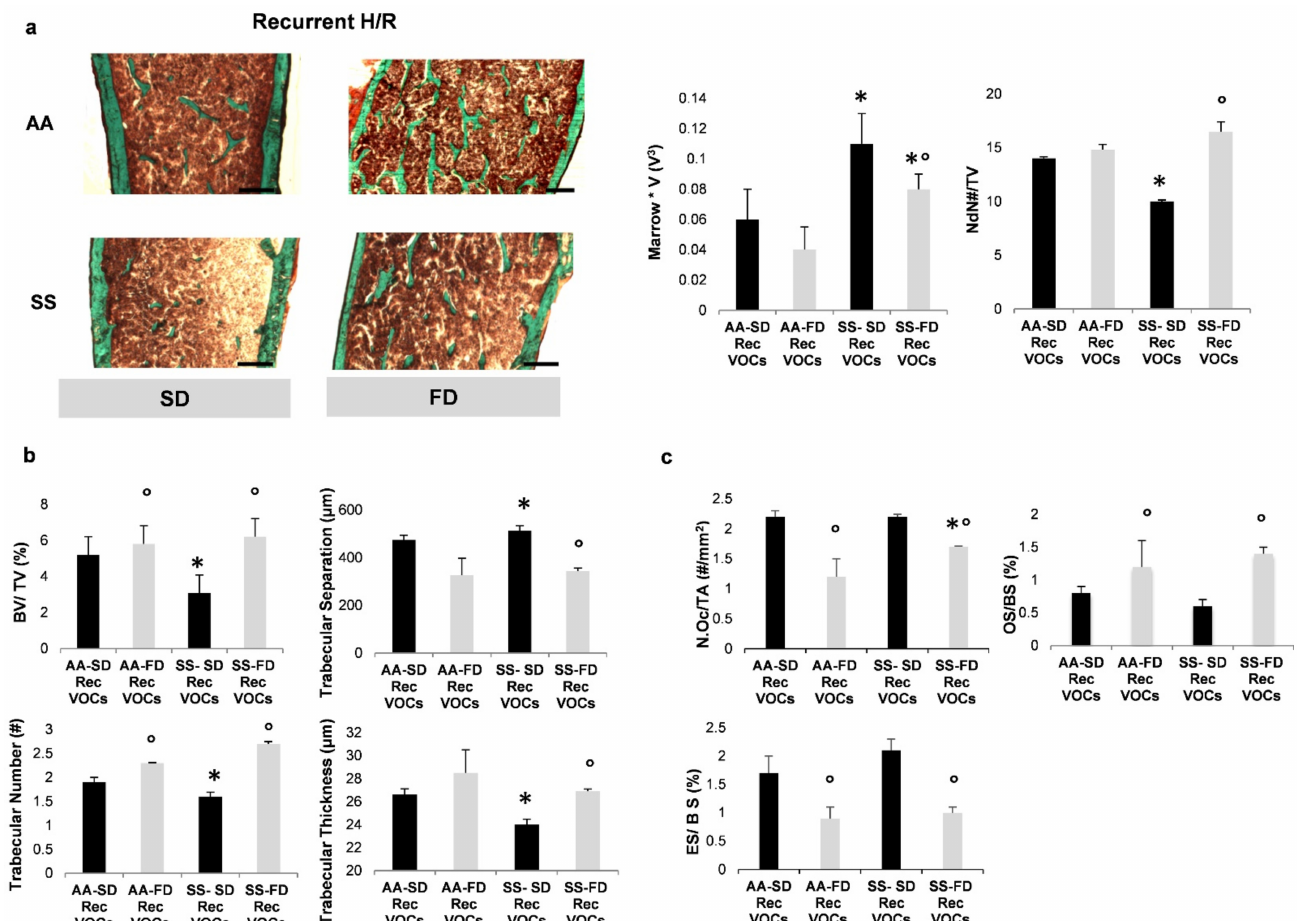
Figure 2. In SCD mice, FD protects bone from recurrent H/R related damage. Quantitative histomorphometric analysis of distal femur of healthy (AA) and sickle cell (SS) mice under either SD or FD supplementation exposed to recurrent H/R. ( a ) Left panel . Representative undecalcified section of distal femur stained with Trichoma Goldener’s stain. Microarchi- tecture was preserved in FD treated mice compared to the SD treated group, expressed as indirect (Marrow Star Volume, M*V) and direct (Node Number, NdN#/TV) parameters ( right panel ). Scale bar: 1 µ M. ( b ) Bone Volume (BV/TV) and trabecular parameters were better in the FD treated group compared to the FD group. In particular, the Trabecular Number and Thickness were higher and Trabecular Separation was lower in the FD treated group ( c ) Concerning the cellular activity, the FD group showed reduced osteoclastic number (NOc/TA), increased Osteoblasts Surfaces (OS/BS) and reduced Erosion Surfaces (ES/BS) compared to the SD group. ( a – c ) Data are shown as mean ± standard deviation (SD) ( n = 4; 2 females and 2 males). * p < 0.05 compared to AA; ◦ p < 0.05 compared to